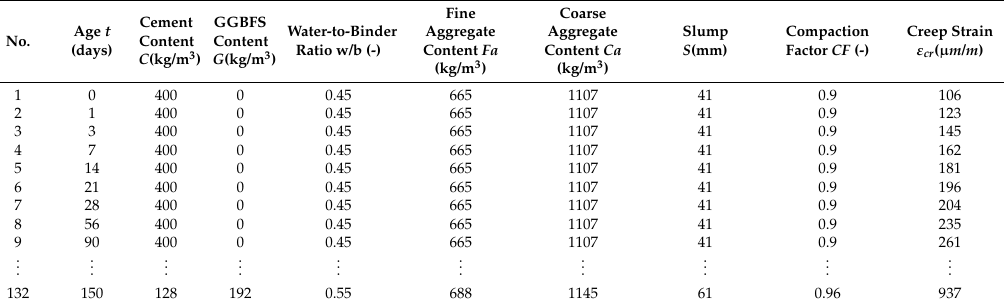
Table 4. Exemplary database (based on [31,33]).